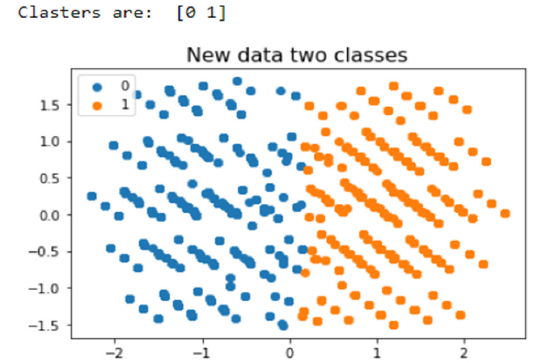
Fig. 16. The reduced dataset format was divided into four classes